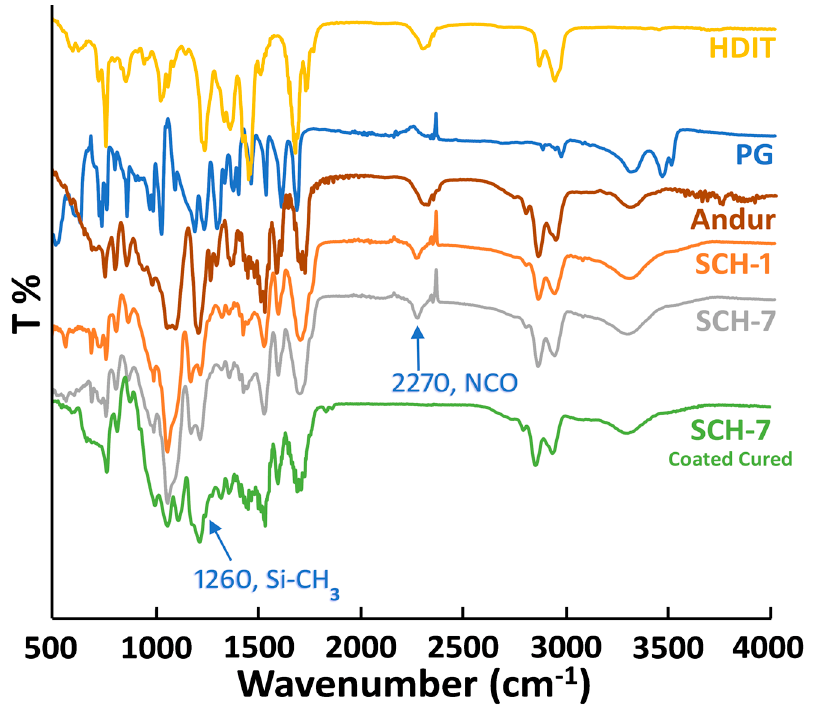
Figure 3. FTIR spectra of the monomers and prepared self-healable bottom layer before and after the grafting of the omniphobic PDMS top layer. Y-axis represents the percentage of transmittance (T %) as a function of wavenumber on the x-axis.